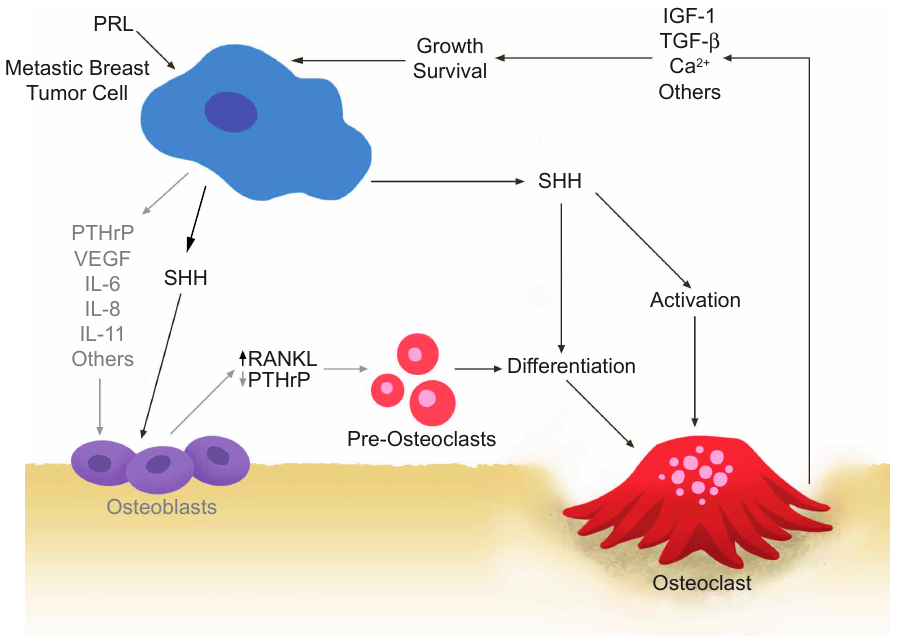
Figure 3. Prolactin (PRL)-stimulated breast cancer cells secrete SHH to induce the differentiation of lytic osteoclasts. High levels of the PRL-receptor (PRLR) in the primary tumor are associated with a shorter time to bone metastasis, presumably due to an acceleration of the vicious cycle.